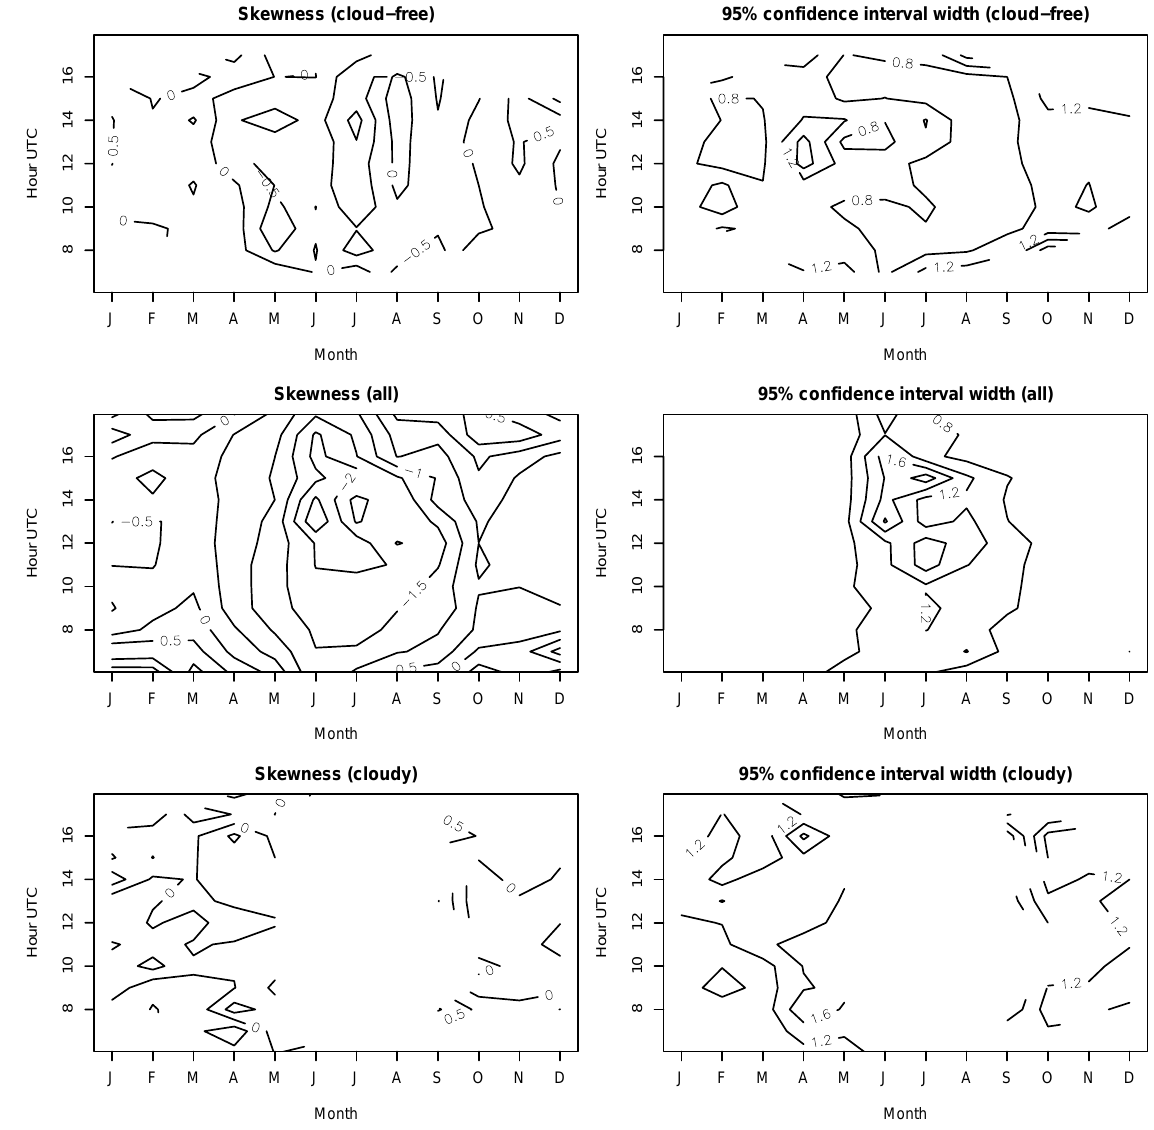
Fig. 13. Isolines of the skewness of hourly ultraviolet erythemal irradiance. of isolines elongates as lower percentiles are